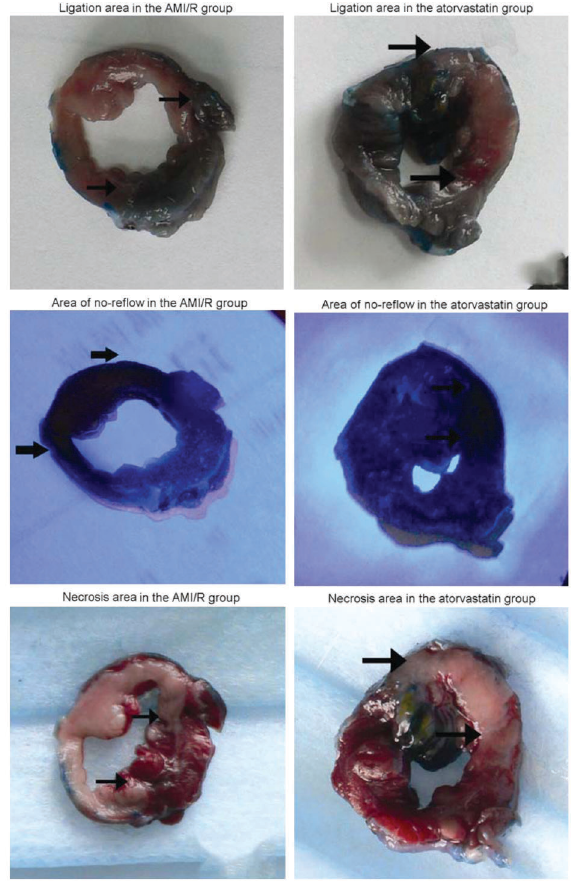
Figure 2. Ligation area, area of no-reflow and necrosis area after 4 h of occlusion and 2 h of reperfusion (pathological staining, 1 6 ). The red areas show the ligation area, black areas show the area of no-reflow, and white areas show necrosis (see black arrows). AMI/R: acute myocardial infarction and reperfusion.